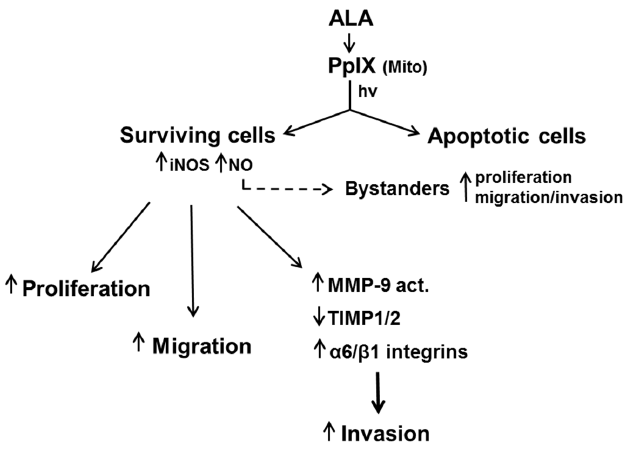
Figure 5. Enhanced NO-mediated growth, migratory, and invasive aggressiveness of cancer cells that survive an ALA-PDT challenge. These responses can apply not only to cells that are direct targets of photodynamic action, but also non-targeted bystander cells which are accessible to NO from targeted cells.